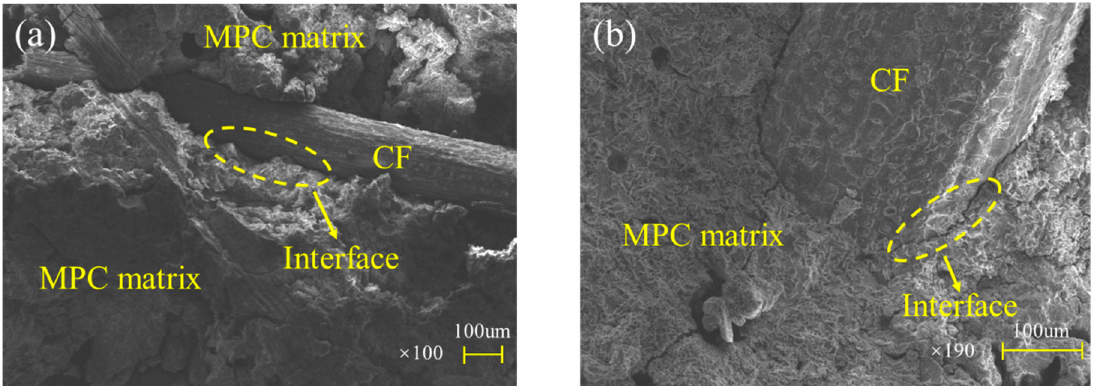
Figure 21. Interface between CF and MPC matrix: ( a ) T7; ( b ) T28.